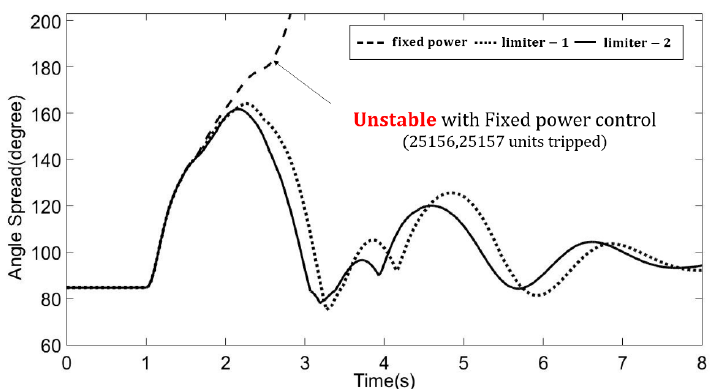
Figure 12. Active power of BTB VSCs with different 𝑃 𝑟𝑒𝑠 .